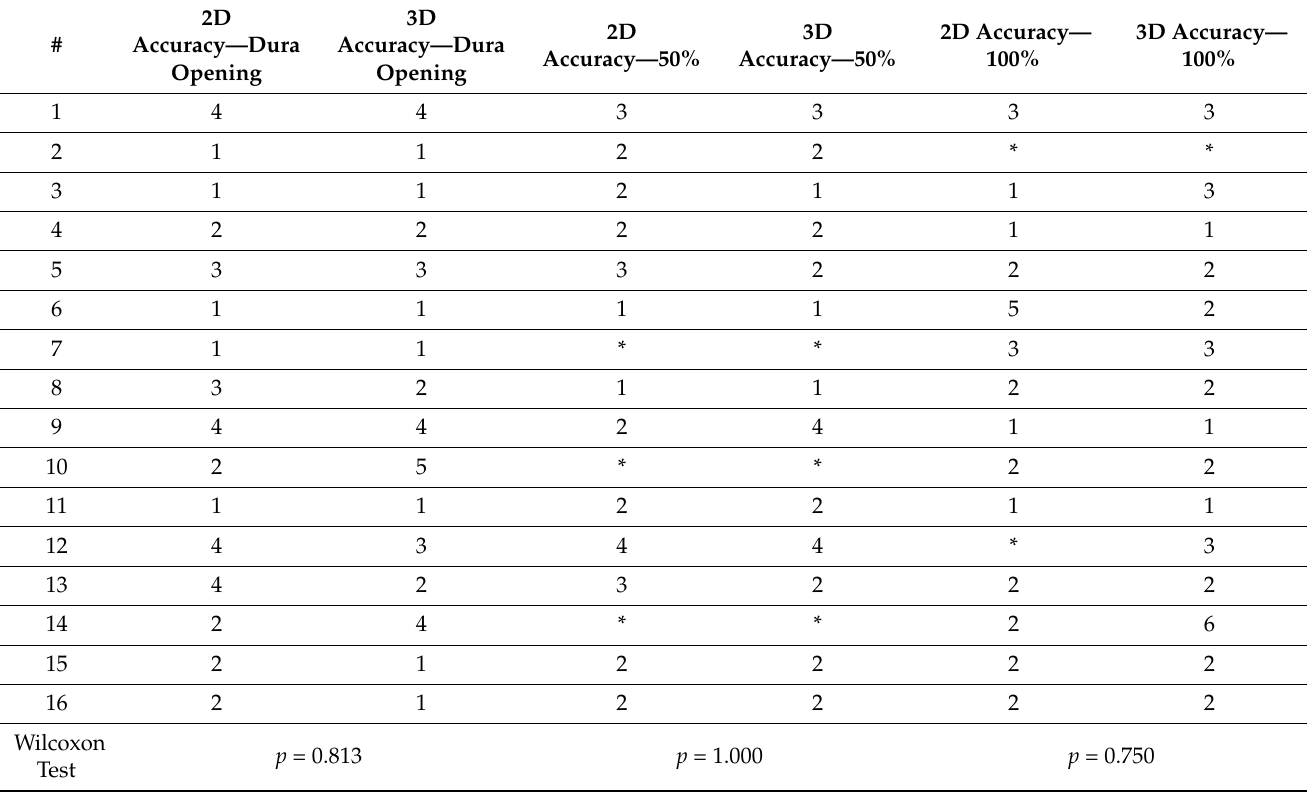
Table A3. Accuracy of iUS raw data with Wilcoxon Signed Ranks Test. * = missing